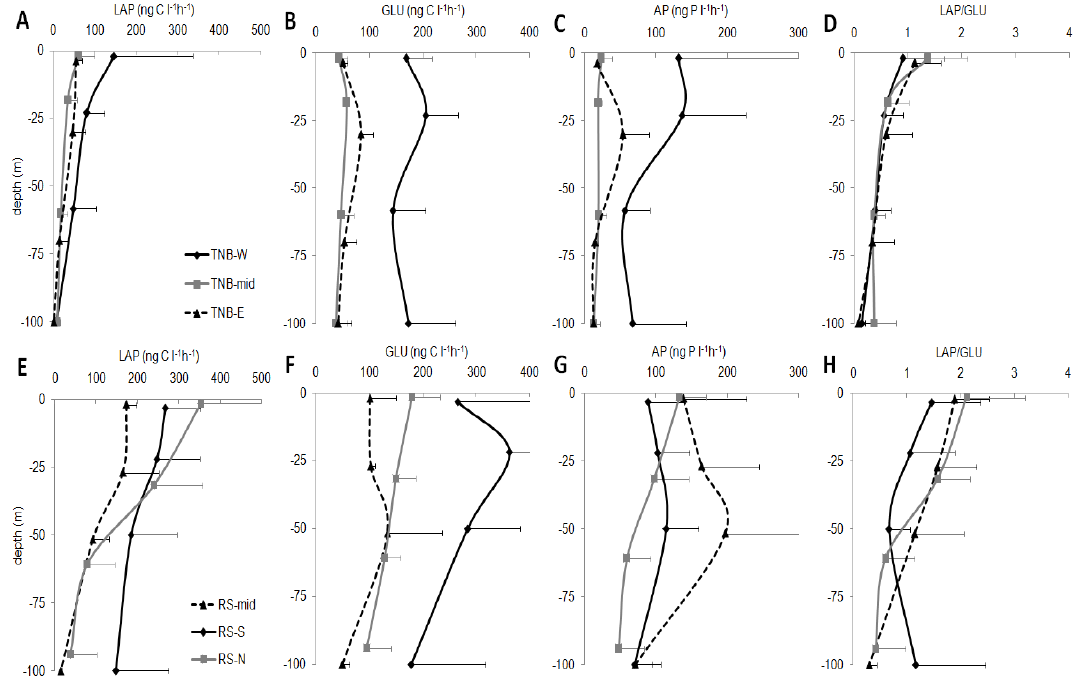
Figure 6. Vertical distribution of enzymatic activities: leucine-aminopeptidase (LAP, ng C L − 1 h − 1 ), β -glucosidase (GLU, ng C L − 1 h − 1 ), alkaline phosphatase (AP, ng P L − 1 h − 1 ), aminopeptidase/β-glucosidase ratio (LAP/GLU) in coastal TNB (upper panels, A – D ) and offshore RS (lower panels, E – H ).